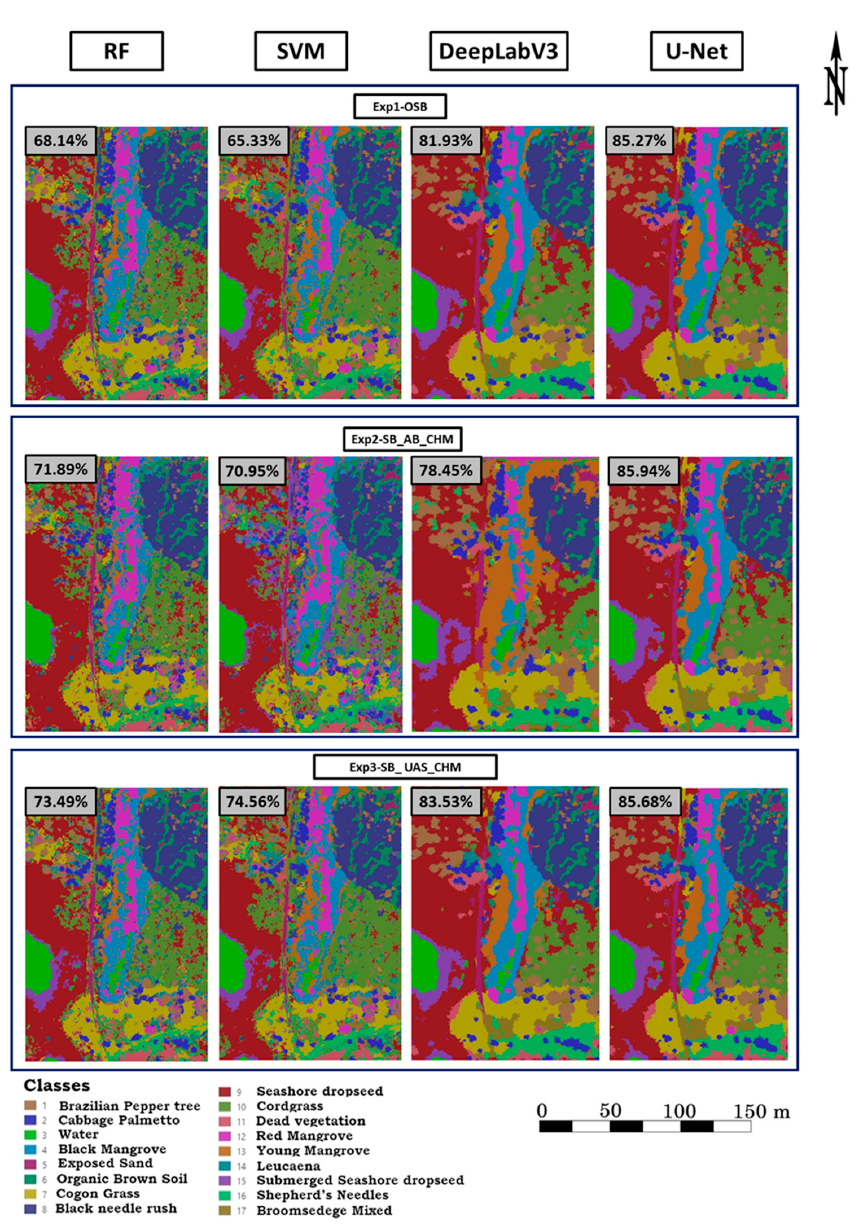
Figure 11. Vegetation maps corresponding to the highest overall accuracies achieved by each of the four classification algorithms for each experiment.